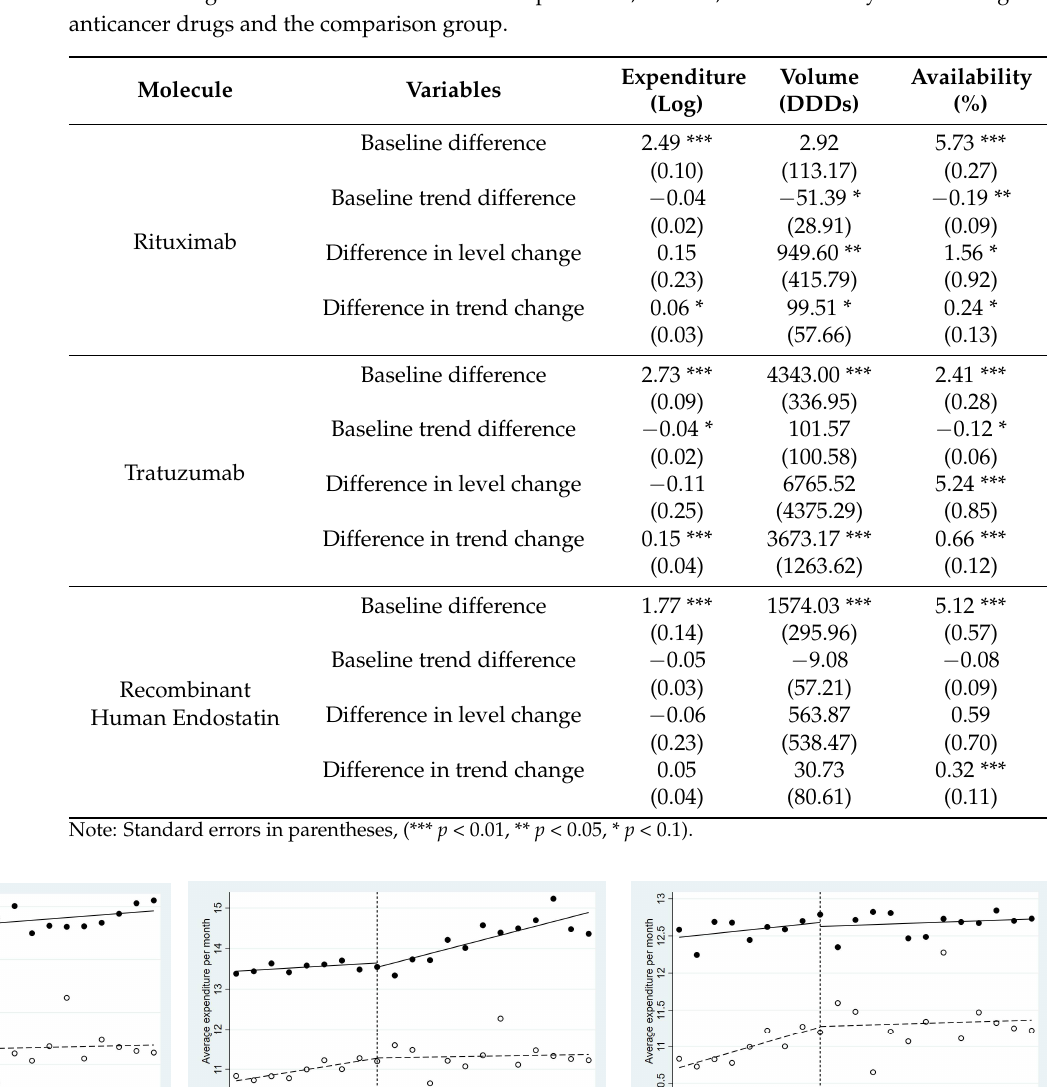
Table 3. Changes in the level and trend of the expenditure, volume, and availability for three tar- geted anticancer drugs and the comparison group.